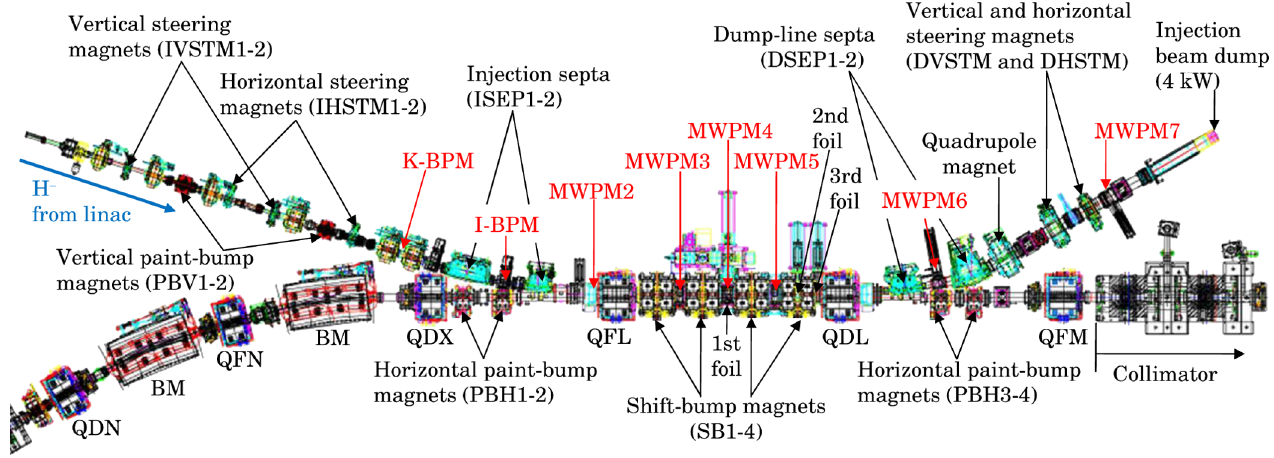
FIG. 2. (Color) Schematic view of the RCS injection area, where the red characters correspond to the beam diagnostics devices defined in Table